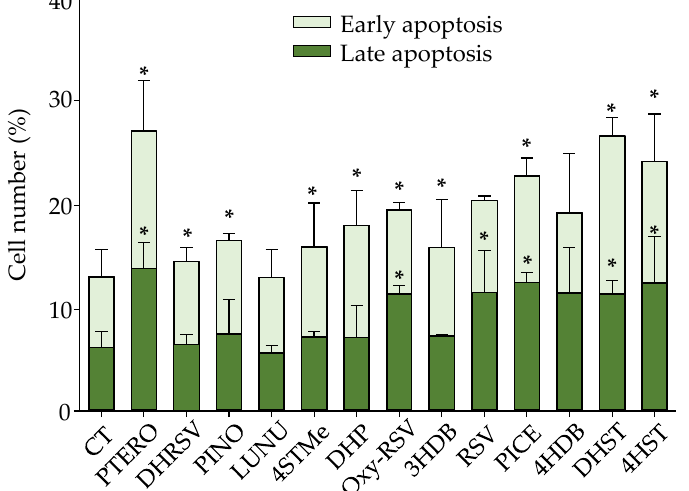
Figure 10. Apoptosis induction in Caco-2 cells after 72 h. IC 50 concentrations (Table 1) were assayed for each compound. Data are shown as the mean ± SD of 3 independent experiments. * p < 0.05 vs. CT.